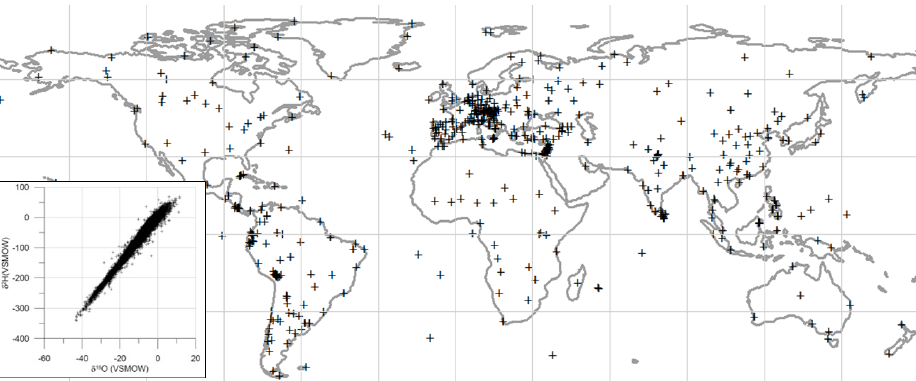
Fig. 1. Global map of GNIP stations used for RCWIP modeling. All stations represented 2 to 52yr of monthly δ 18 O or δ 2 H and climate data from 1960 to 2009. Inset: a cross-plot of δ 18 O versus δ 2 H at stations used, yielding a GMWL of δ 2 H=7.91 δ 18 O+8.72 ( R 2 = 0 . 976, n = 576 ).